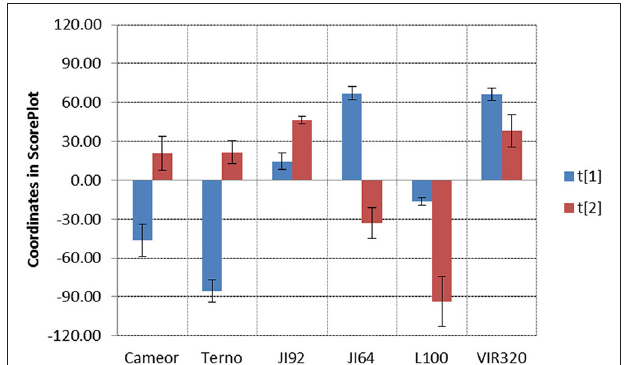
FIGURE 5 | Score Plot of LC/ESI-MS data of dormant and non-dormant pea genotypes. Data filtration threshold 1000 counts in MS spectrum; replicated analyses, three repetitions of each genotype, level of significance α = 0.05, UV scaling, no transformation.